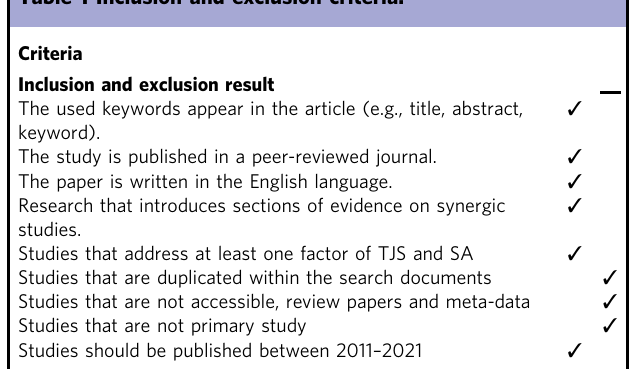
Table 1 Inclusion and exclusion